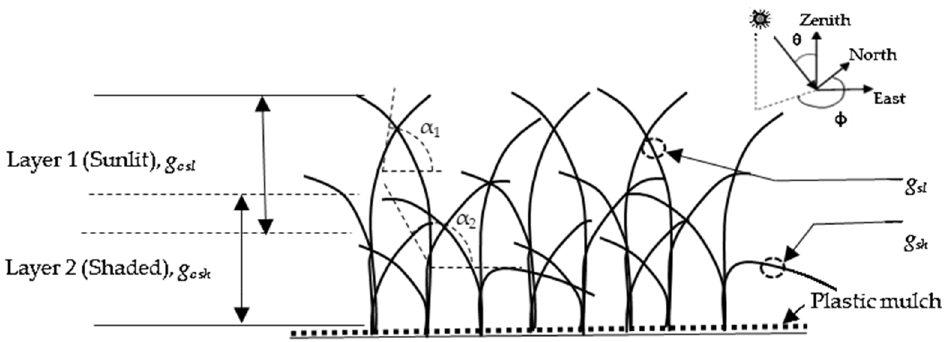
Figure 1. Schematic representation of the canopy structure for tall fescue ( Festuca arundinacea var. Demeter) and the relevant parameters. The proportion of each layer can be theoretically calculated in terms of leaf area index LAI and varies with canopy LAI.